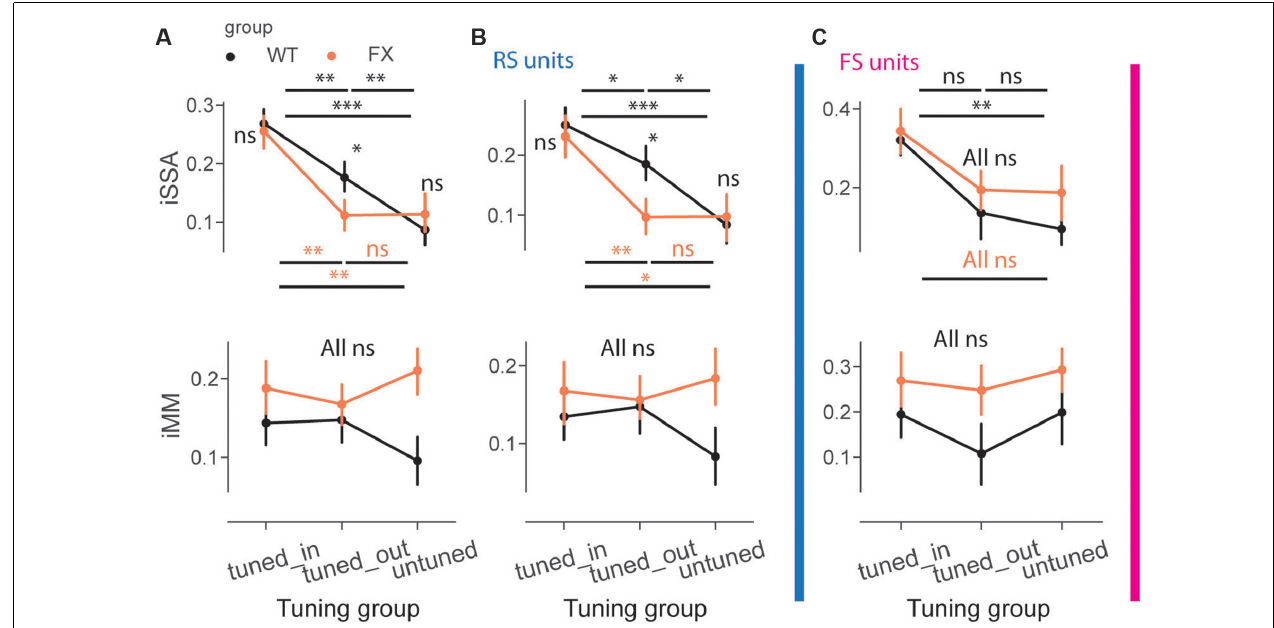
FIGURE 6 | Adaptation depends on the preferred SF of the units. (A) The point plots show iSSA and iMM magnitude for tuned_in, tuned_out, and untuned group for WT and FX for all units. (B) Same as in (A) , but for RS units. (C) Same as in (A) , but for FS units. ∗ p < 0.05, ∗∗ p < 0.01, ∗∗∗ p < 0.001, ns = not significant.